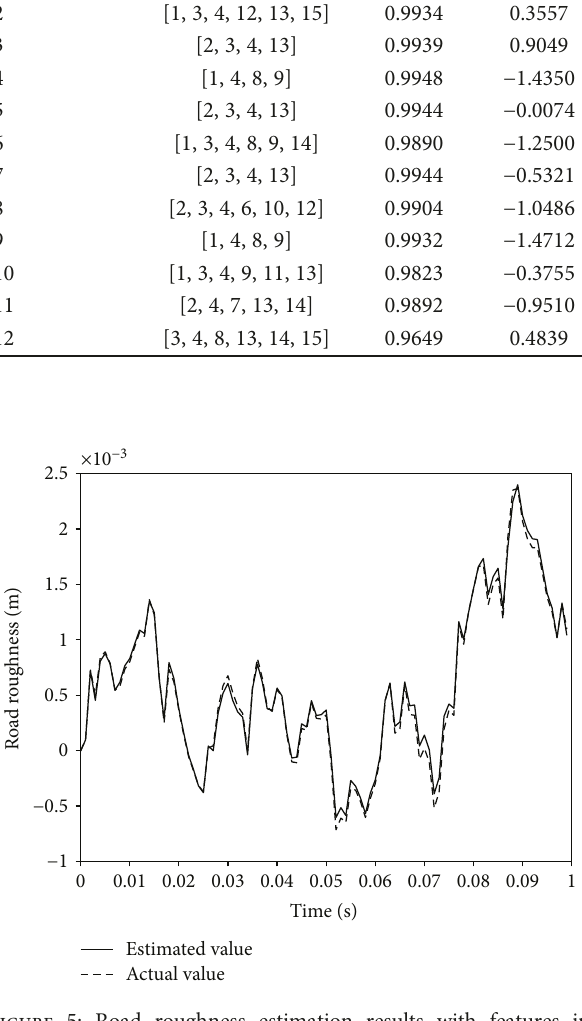
Figure 5: Road roughness estimation results with features in Experiment 3.